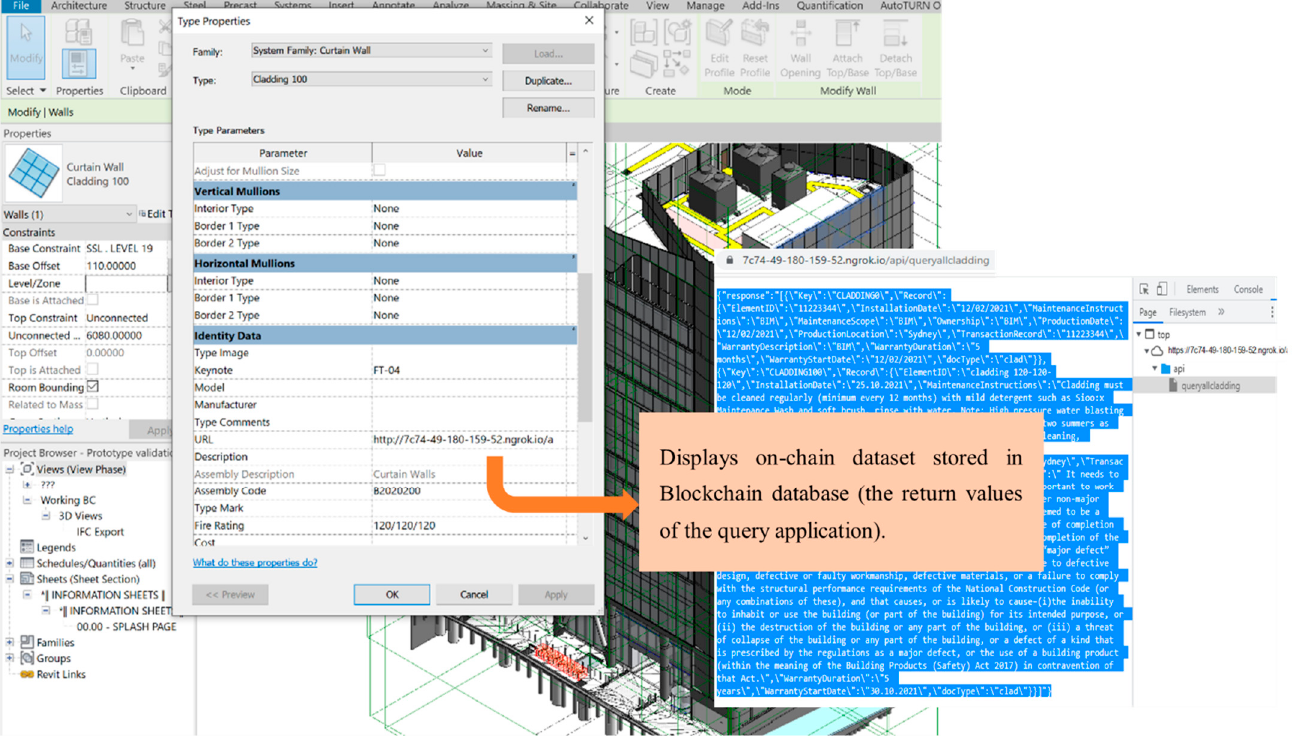
Figure 8. Implementation of the DynaWeb package in the Dynamo workplace environment.